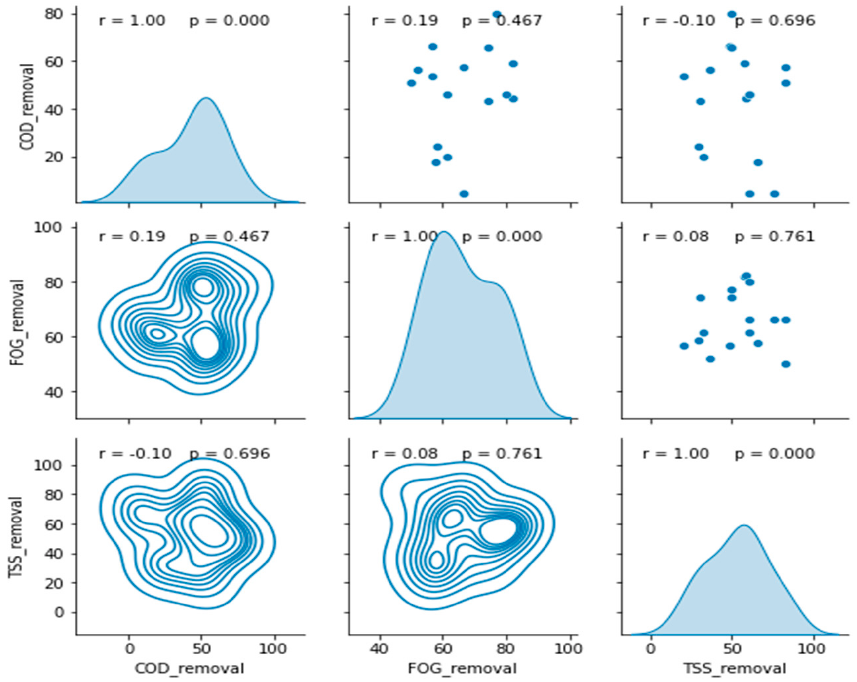
Figure 7. Correlation matrix between the pre ‐ treatment removal efficiencies.